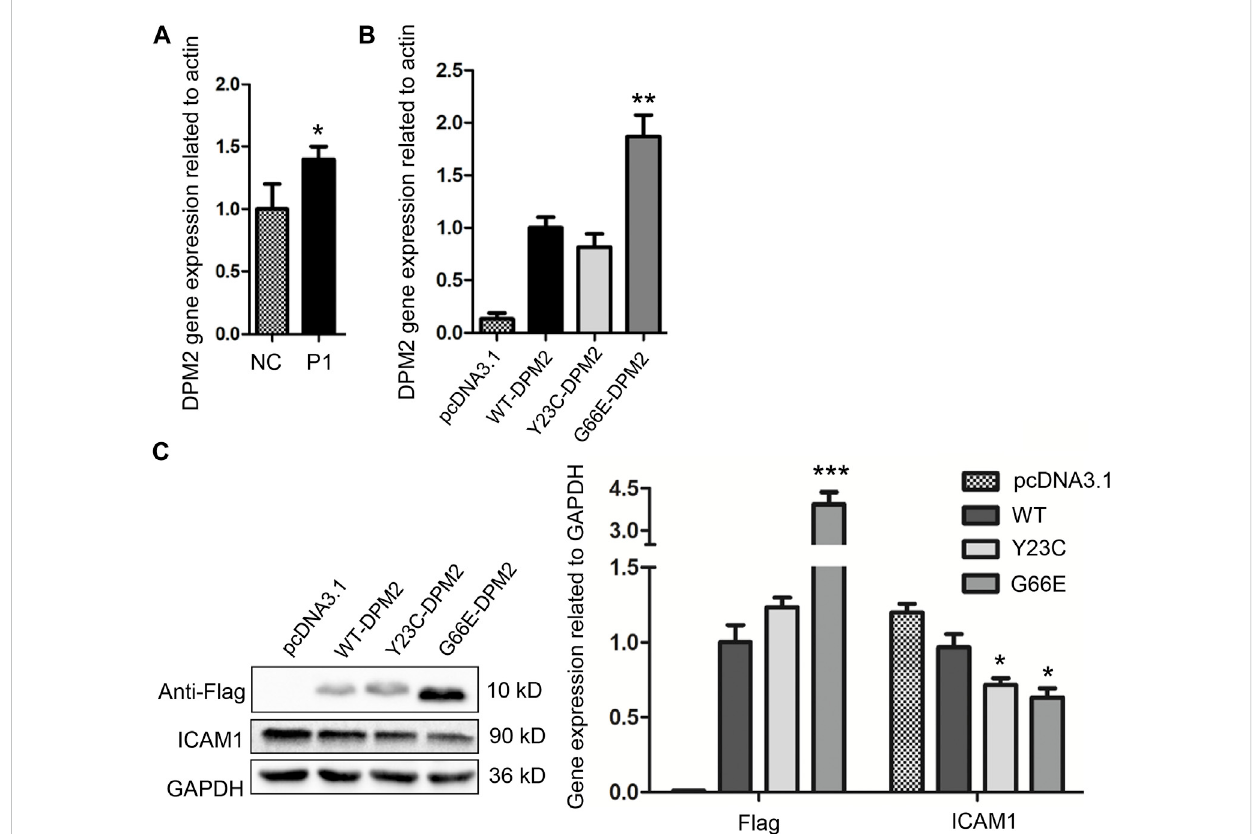
FIGURE 2 Expressionlevelof DPM2 inPBMCsofpatient1andnormalcontrol (A) . (B) Expressionlevelof DPM2 mRNAinHCT116cellstransfectedwithwildtype ormutant DPM2 . (C) ProteinexpressionlevelofDPM2andICAM1inHCT116cells.NC,normalcontrol;P1,patient1(*, p < 0.05;**, p < 0.01;***, p < 0.001).